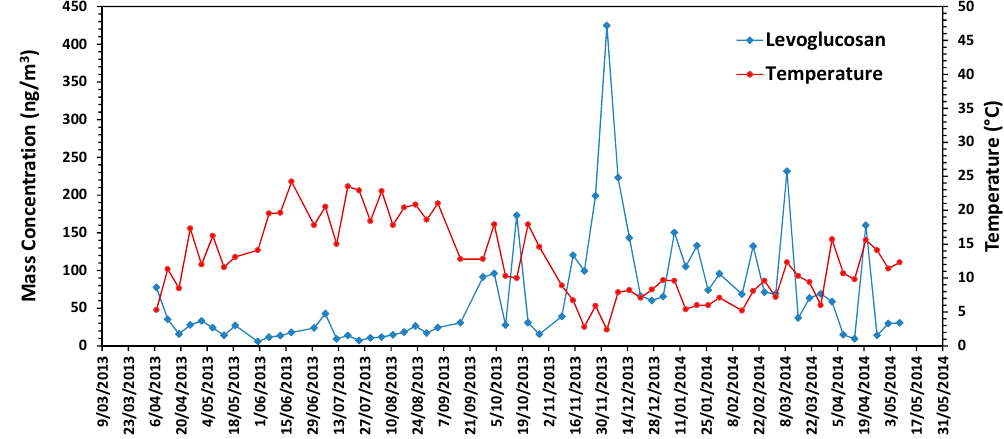
Figure 5. Time series of levoglucosan concentrations and average daily temperature.